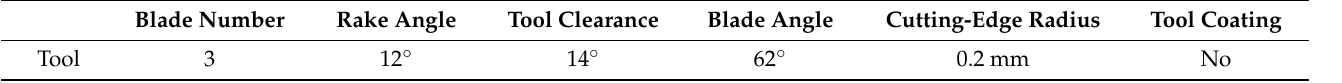
Table 2. The geometric parameters of the tool. Blade